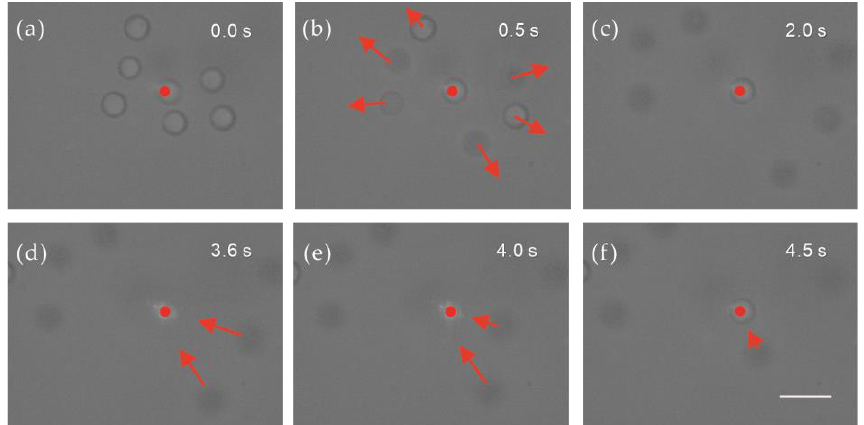
Figure 5. Particles motion under thermophoretic force and convective drag force. ( a , b ) A particle is trapped in trap center and the surrounding particles are pushed away from trap center by thermophoretic force; ( c ) Repelled particles stop moving; ( d , e ) Particles are driven to trap center by convective drag force. ( f ) A particle is trapped. Scale bar, 10 μm. Red dot indicates the laser focal spot. Red arrow indicates the moving direction of microparticle.